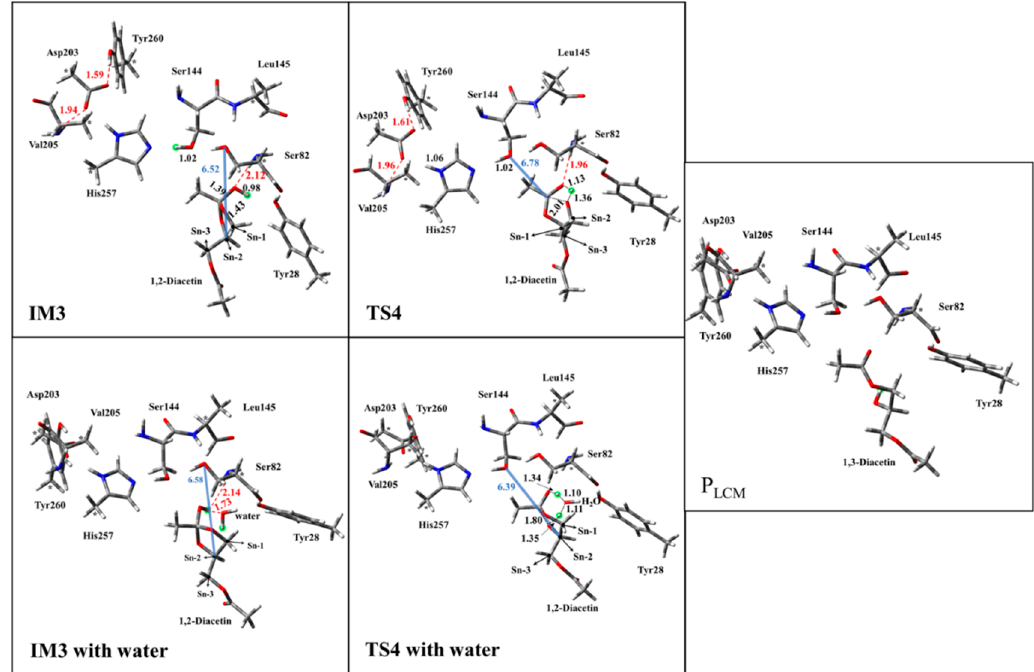
Figure 7. Optimized structures of the transition state (TS4, TS4 with water), intermediate (IM3, IM3 with water), and product (P LCM ) of the enzyme-substrate complex in the LCM of the AM. Red dashed lines represent the hydrogen bond. The hydrogen bond distances are represented by the red dashed line, the distance between substrate and catalytic triad are marked as the blue solid line, all distances are given in angstroms, and the asterisks (*) stand for the fix atoms during geometry optimization.